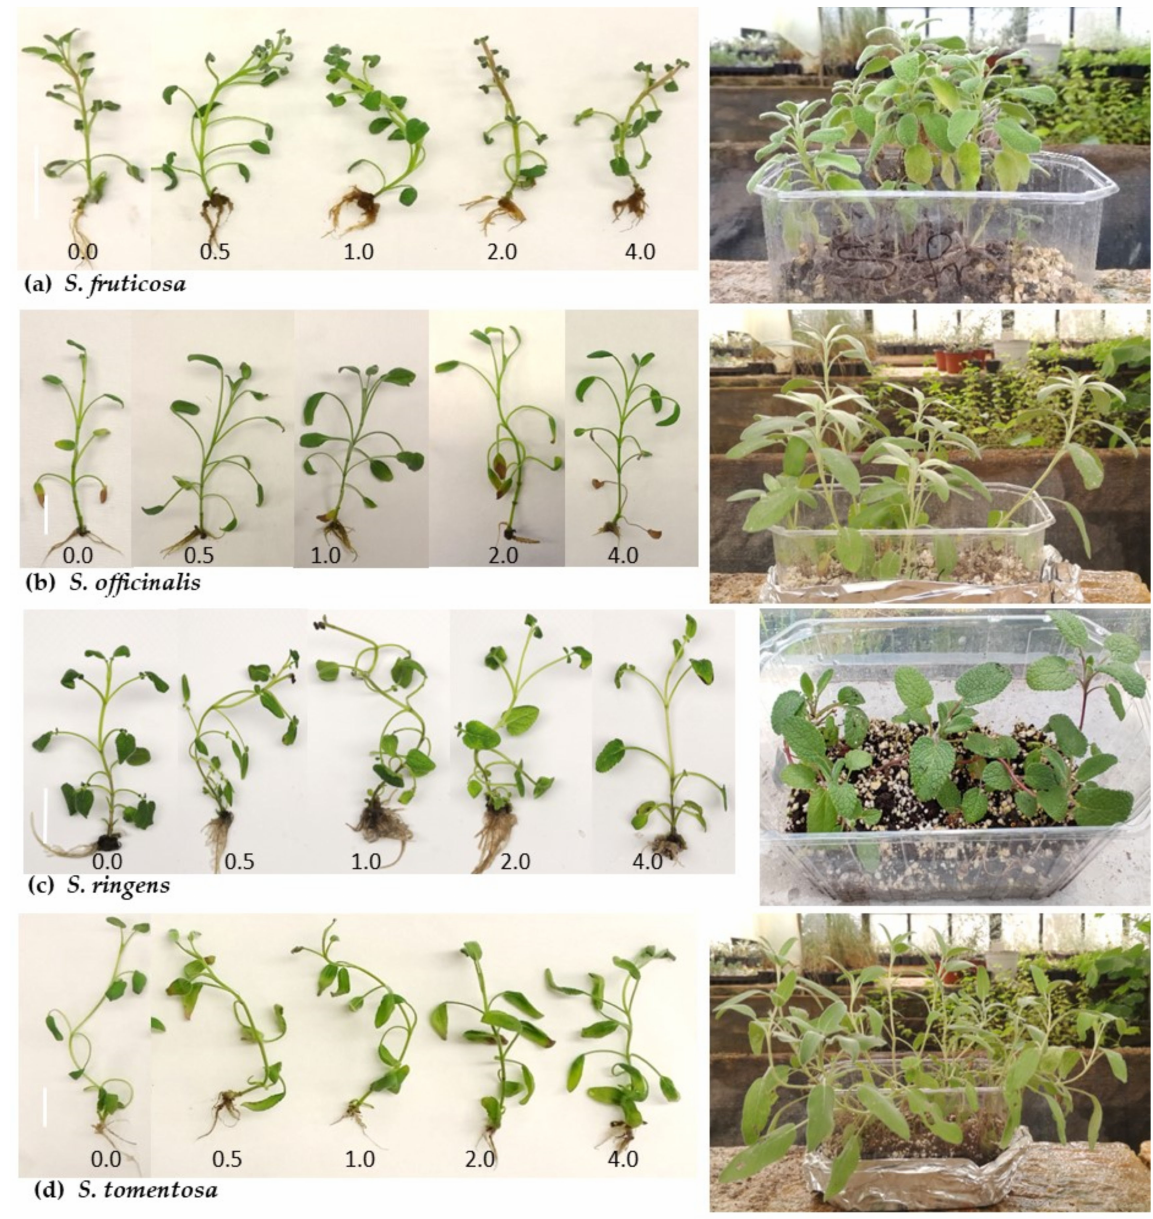
Figure 12. Typical in vitro rooting of Salvia fruticosa ( a ), S. officinalis ( b ), S. ringens ( c ) and S. tomentosa ( d ) microshoots, cultured on 1 MS medium supplemented with IBA at concentration (mg.L − 1 ) marked 2 ( left ), and ex vitro acclimatized plantlets about 6 weeks old ( right ). Size bars = 1.0